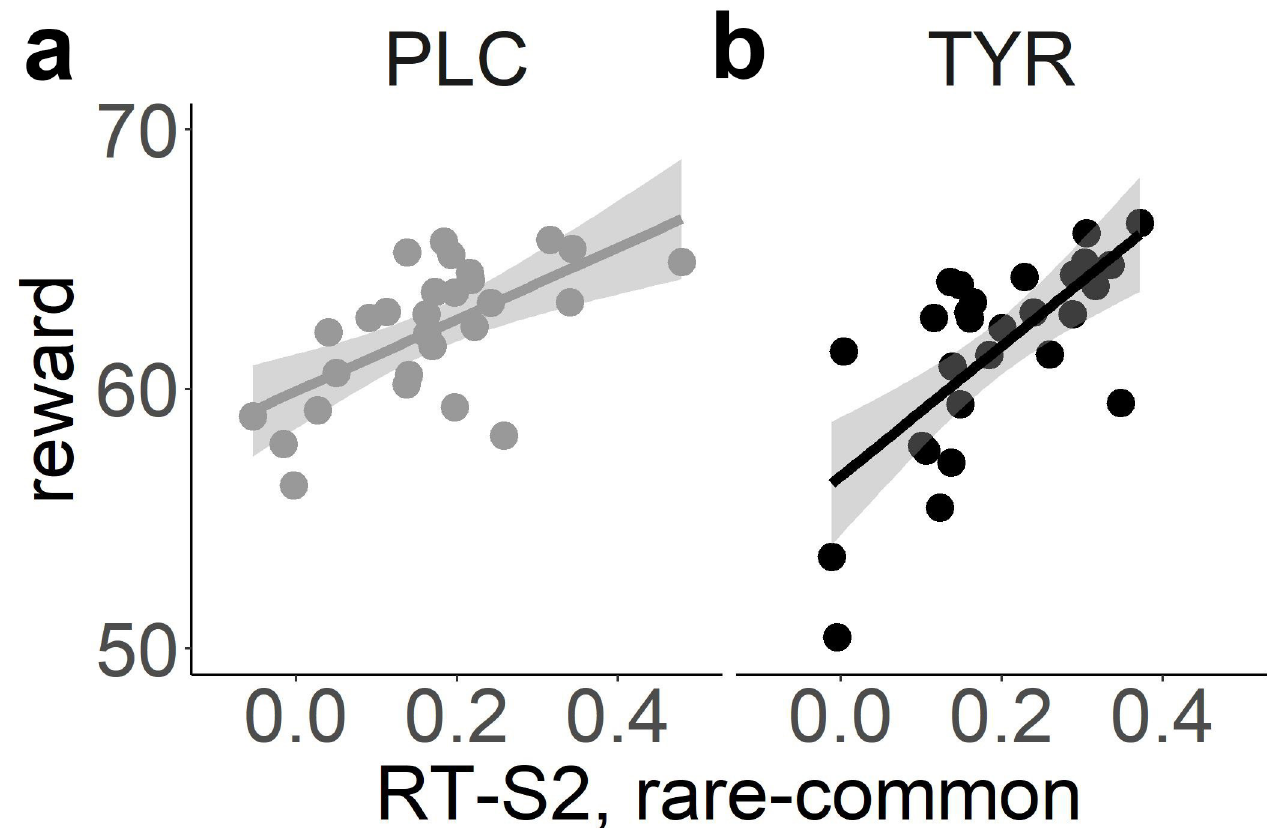
Fig 4. Correlation of participants’ mean rewards per trial and the differences in S2 RTs following a rare vs. a common state transition for the placebo (A) and tyrosine (B) condition.